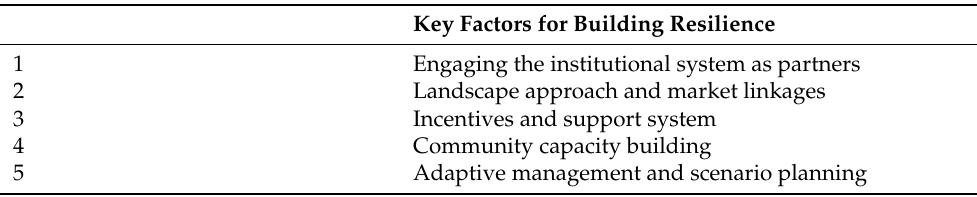
Table 3. Five key factors for building resilience in rural